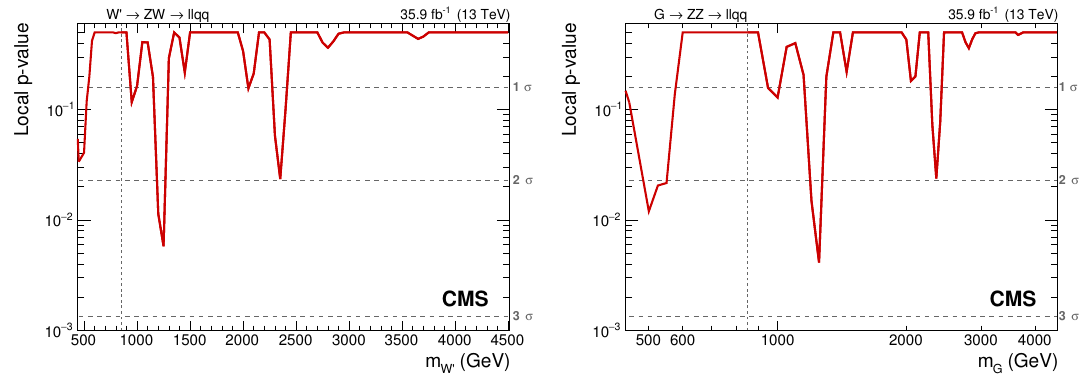
Figure 7 . Observed local p -values for W 0 (left) and G (right) narrow resonances as a function of the resonance mass. The dashed vertical line represents the transition from the low-mass to the high-mass analysis